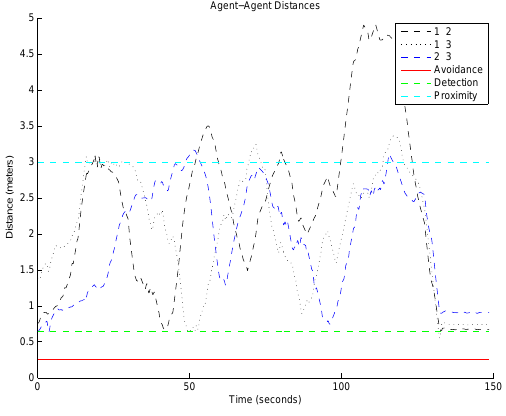
Fig. 15. Pairwise robot distances of Experiment